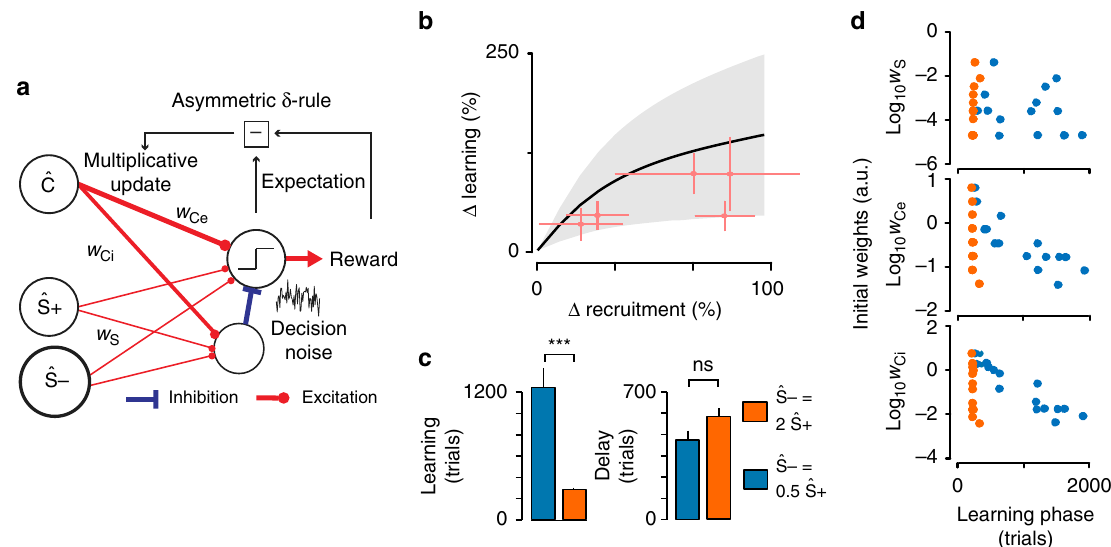
Fig. 4 A multiplicative reinforcement learning model reproduces modulations of learning speed by neuronal recruitment. a Schematics describing the auditory Go/NoGo discrimination model. b Mean±standard deviation of the difference of learning phase duration against difference in neural recruitment by the stimuli for the model initialized with 15 sets of initial conditions obtained when fi tting learning curves from a previous study 25 . The experimental observations of Fig. 3d are superimposed in red. c Mean±standard errors for the learning and delay phases obtained with the model for a twofold difference in cortical recruitment between the two stimuli. A longer learning phase (Kolmogorov – Smirnov test, p = 8 × 10 − 7 indicated as ***, n = 15 initial conditions per group) but not delay phase (Kolmogorov – Smirnov test, p = 0.13 indicated as ns, n = 15 initial conditions per group) is observed when S − recruits less activity (blue) as compared to when S − recruits more activity than S + (orange). d Learning phase duration plotted against the value of the modeled initial synaptic weights. Same simulations and color code as in c . Signi fi cant correlations were observed only when S − recruits less activity (blue), and for w Ce ( ρ = − 0.61, p = 0.015, n = 15) and w Ci ( ρ = − 0.70, p = 0.0034, n = 15). Error bars represent standard errors (SEM). Source data are provided as a